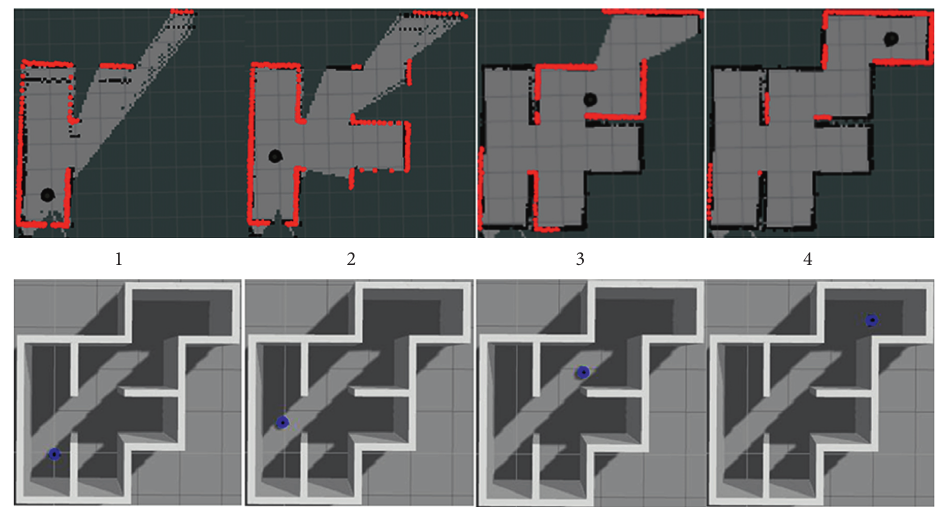
Figure 5: Mapping result of Hector-SLAM